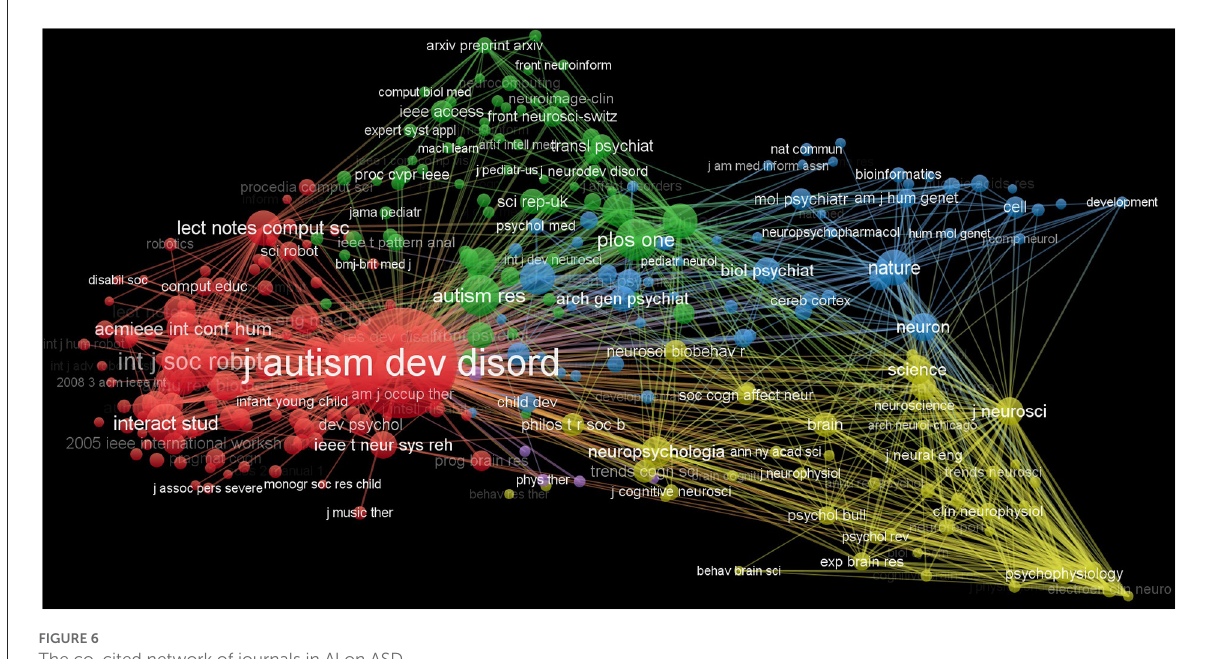
FIGURE6 The co-cited network of journals in Al on ASD.